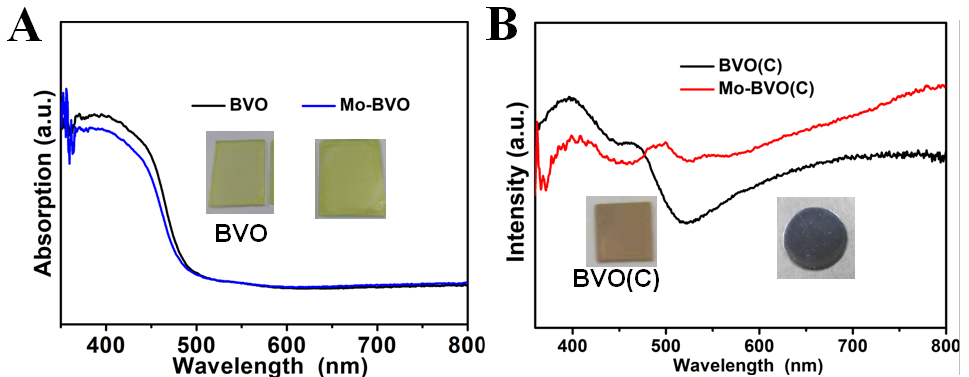
Figure 2. ( A ) UV-vis DRS of BVO and Mo-BVO. ( B ) UV-vis DRS of BVO (C) and Mo-BVO(C). The inset shows the digital photos of BVO, Mo-BVO, BVO(C), and